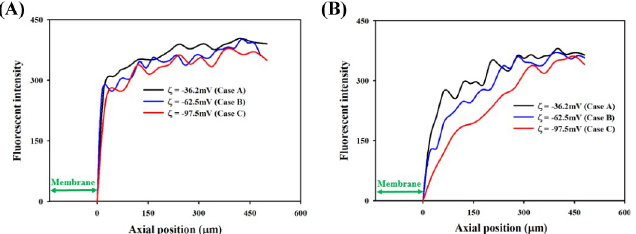
Fig 3. Variations of IDZ intensity formed near the charged membrane. The fluorescent intensity of sum of PFD and NFD was analyzed using three membranes with different SZP Magnitude. The fluorescent profile was calculated using the membrane marked by the green arrow. Formation of IDZ means ion depleted solution compared to feed solution is obtained. This result indicated the concentration distribution along the microchannels (A) a 55 μ m and (B) a 10 μ m.